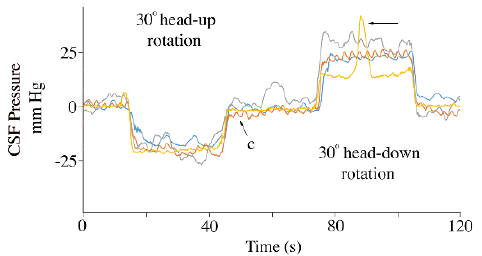
Figure 3. Influence of orthostatic gradients on the cerebrospinal fluid pressure. Traces from four individuals of Alligator mississippiensis (individuals’ traces are color coded), all showing similar scales of decreased CSF pressure during head-up rotations and increased CSF pressure during head- down rotations. One of the alligators coughed during the head-up rotation (arrow). c—individual cardiac-related pulsation.